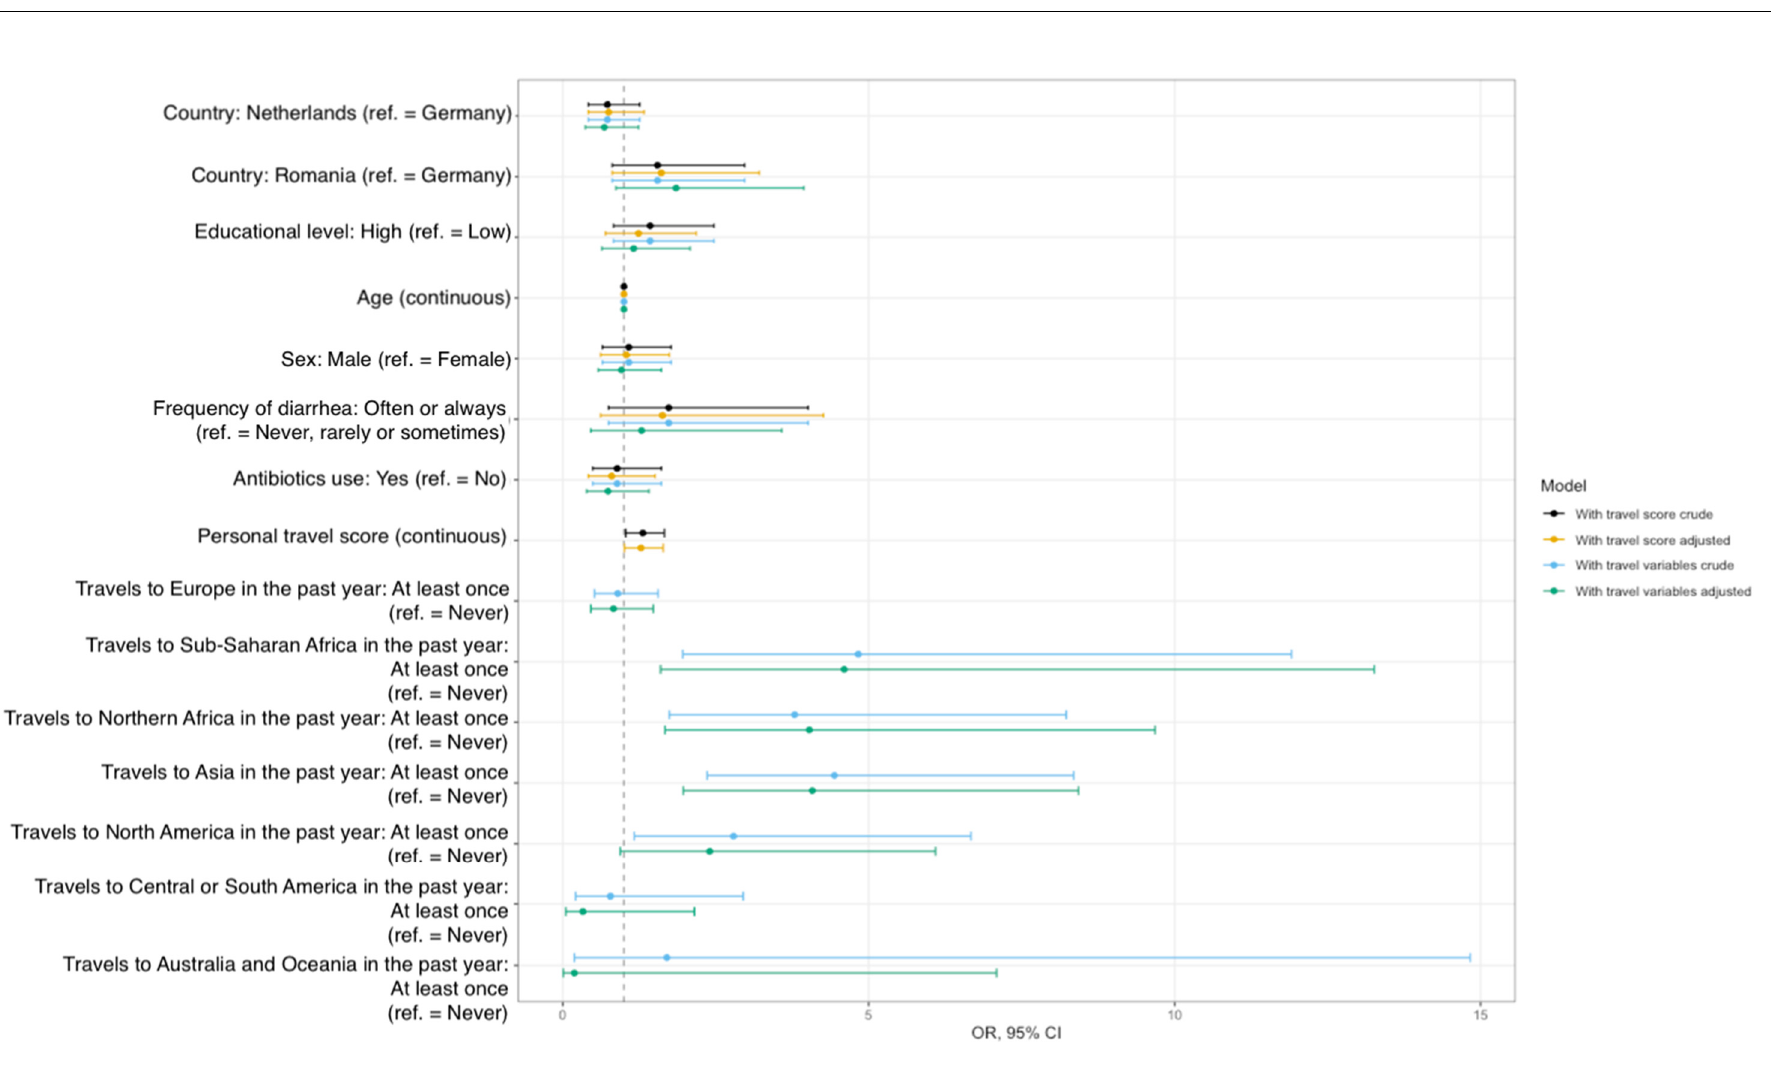
Figure 1. Risk factor analysis for carriage of ESBL-producing E. coli in stool samples.